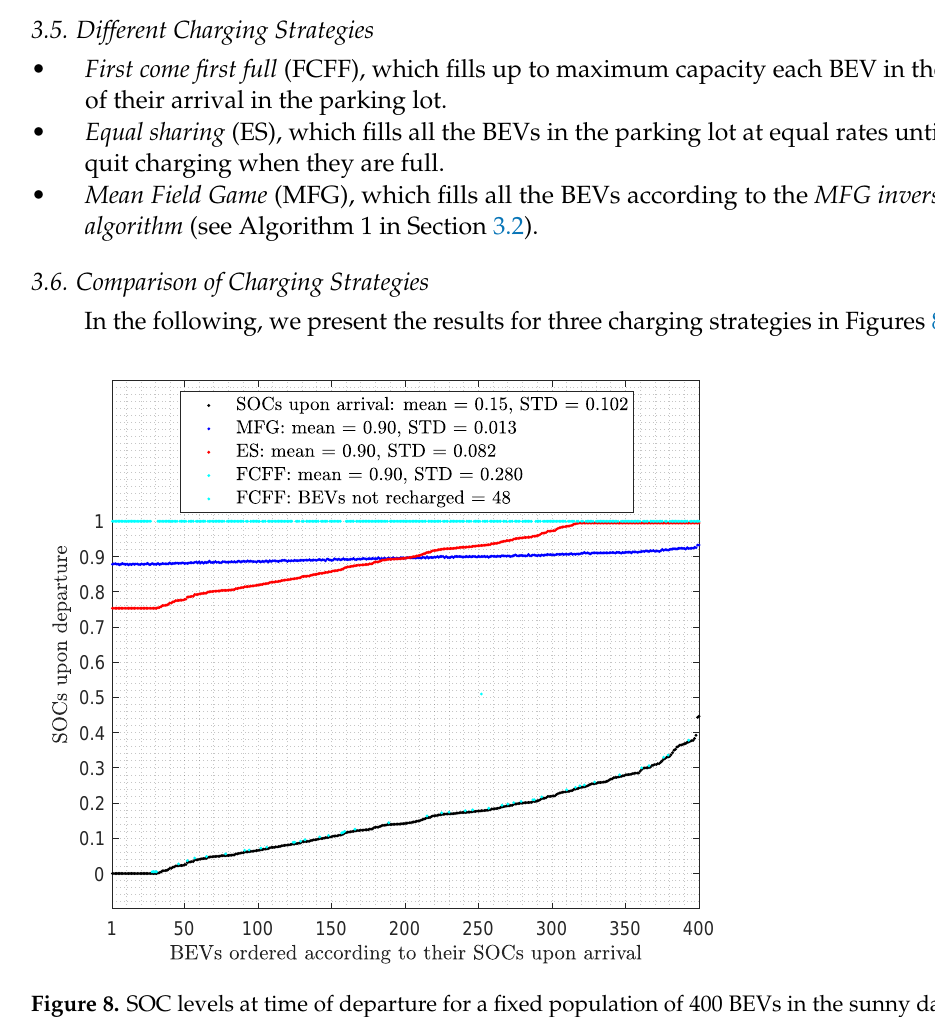
Figure 8. SOC levels at time of departure for a fixed population of 400 BEVs in the sunny day.